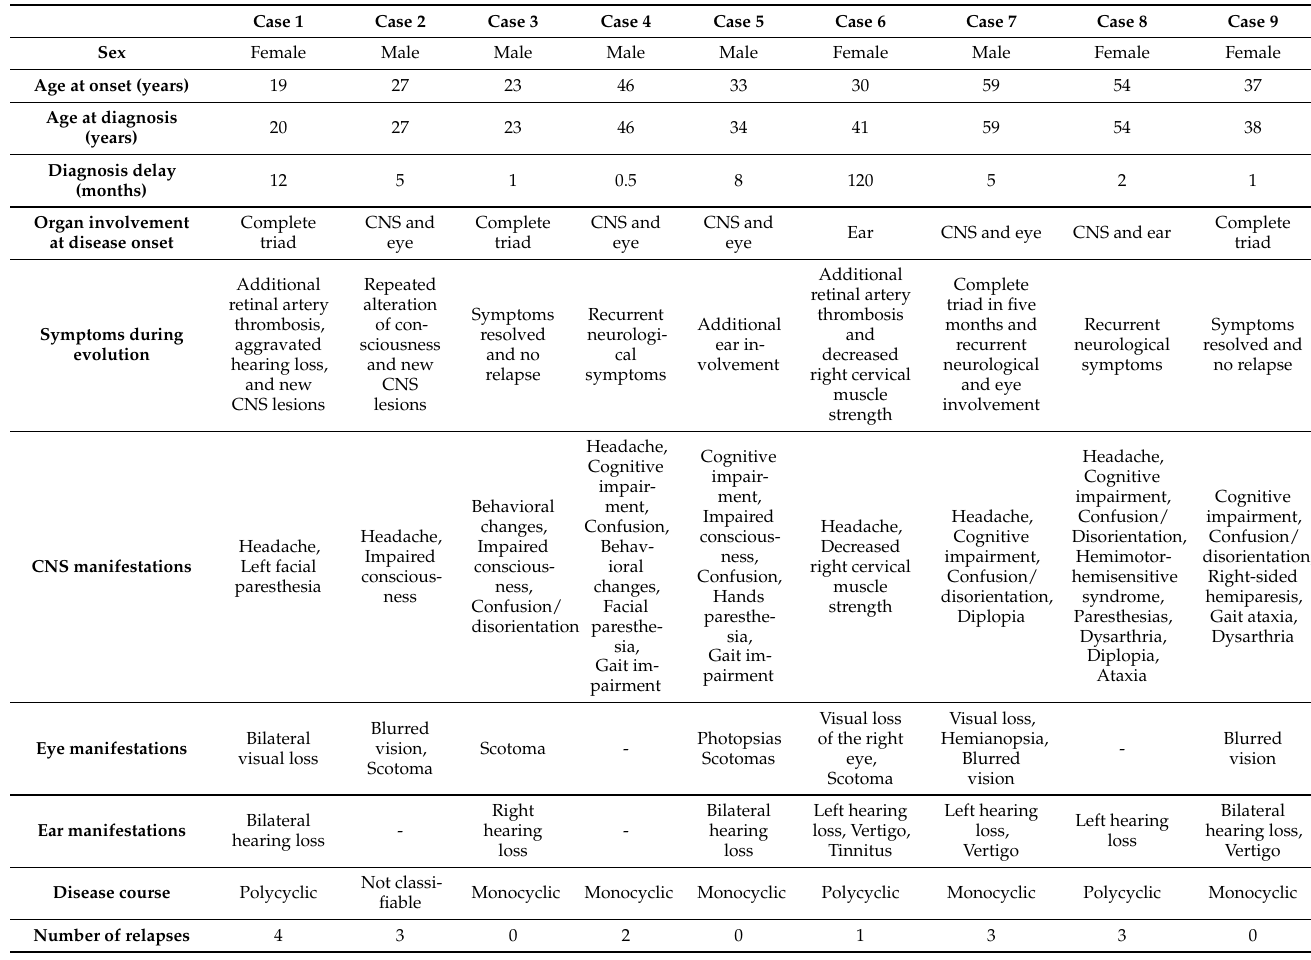
Table 1. Demographic and clinical characteristics of nine patients with Susac syndrome.